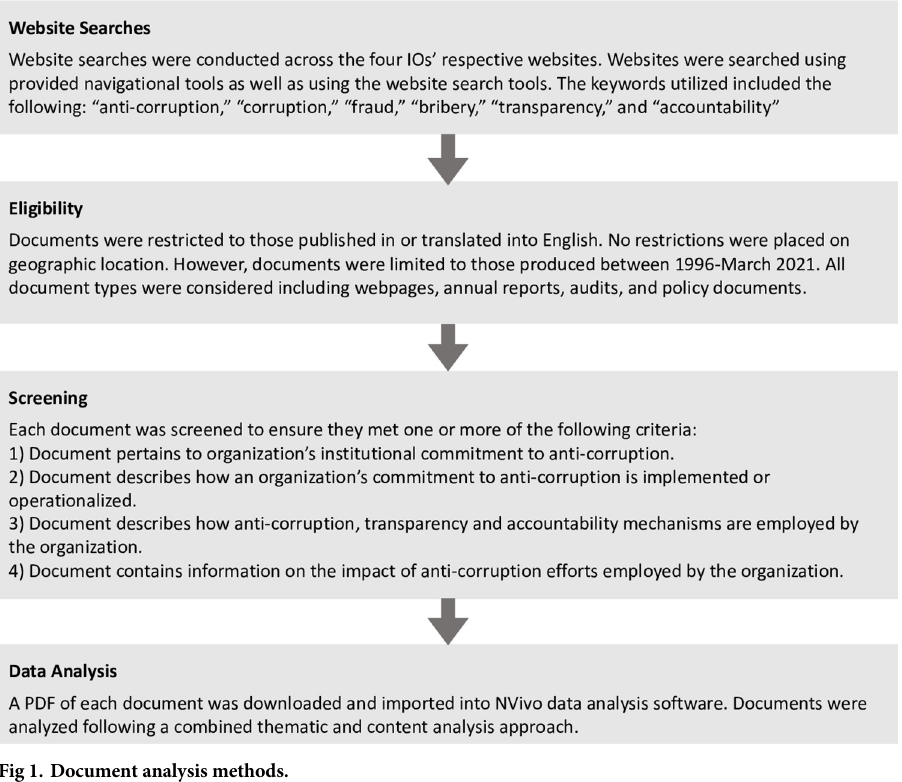
Fig 1. Document analysis